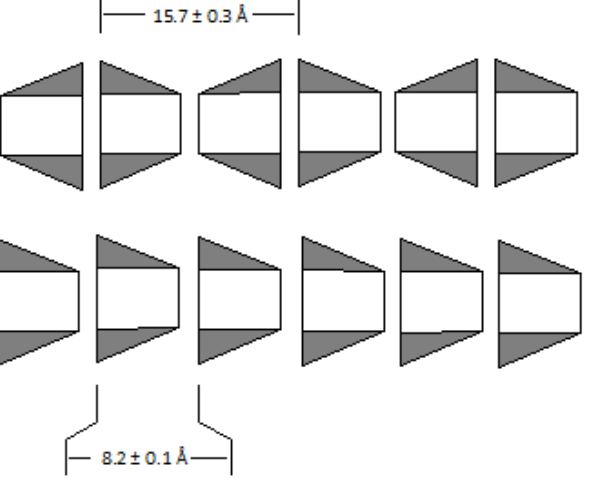
Figure 1. Hydrogen bonded assembly of cyclodextrins in solid state. Head-to-head assembly of β -CD with a repeat distance of 15.7 ± 0.3 Å ( top ) and head-to-tail assembly of α -CD with repeat distance of 8.2 ± 0.1 Å ( bottom